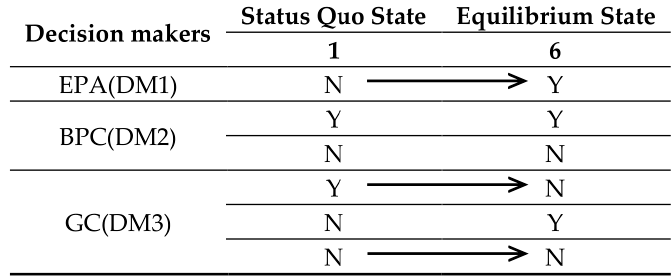
Figure 6. Evolution of Changzhou Conflict from the Status Quo to the Final Resolution.